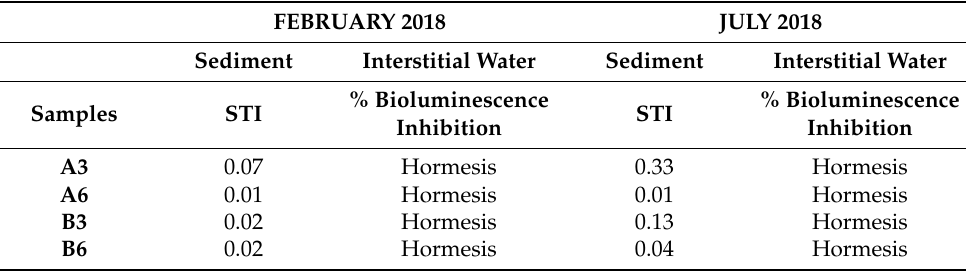
Table 6. Microtox bioassay results.